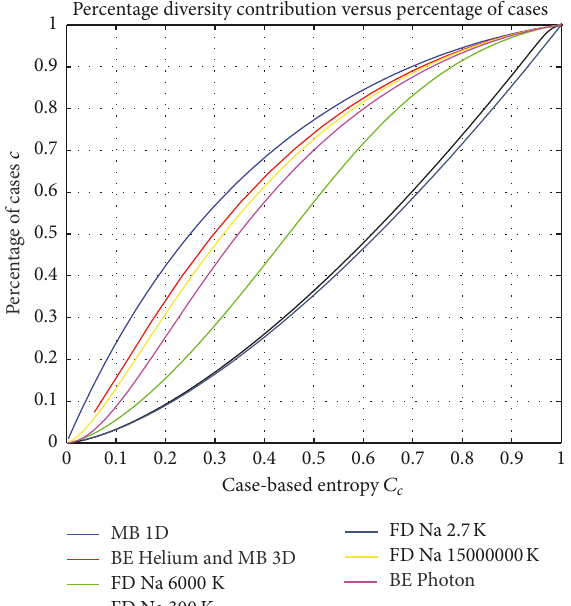
Figure 7: Superposition of all diversity curves for Boltzmann 1D, Boltzmann 3D, Bose-Einstein Helium, Bose-Einstein Photon, and Fermi- Dirac Na at 2.7 K, 300 K, 6000 K, and 15000000